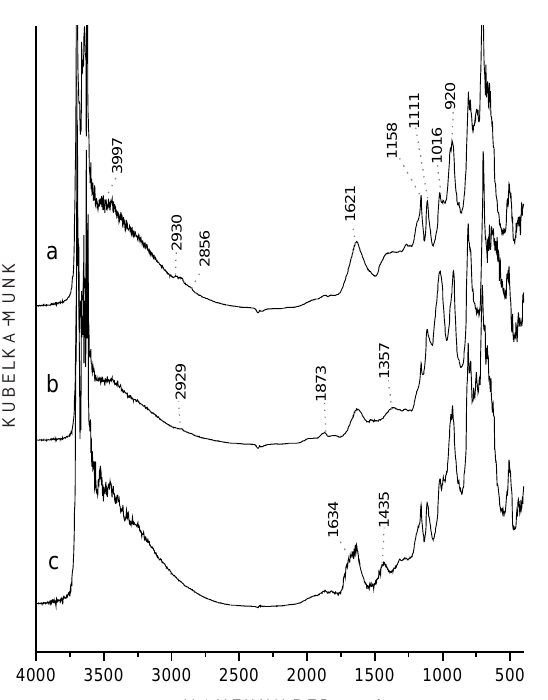
Figure 2. DRIFT spectra of the whole soil (a), of the HS-extracted soil (b) and of the oxidized soil (c) of the Latosol.